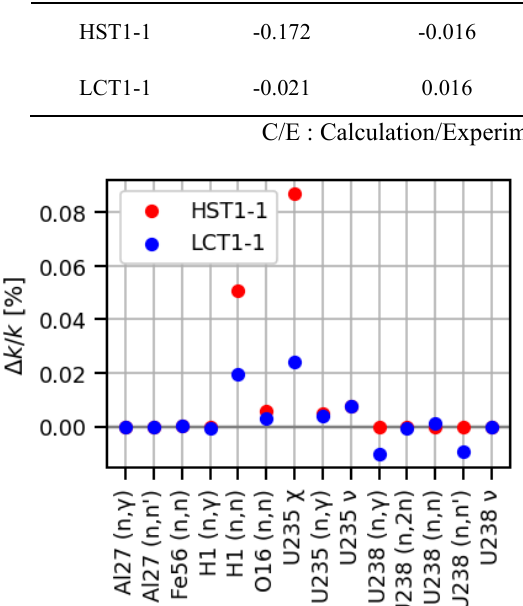
Figure 1. The amount of change in criticality due to each nuclide reaction by the cross-section adjustment method ( Δ𝑘 𝑘⁄ > 1.0 × 10 −5 % )